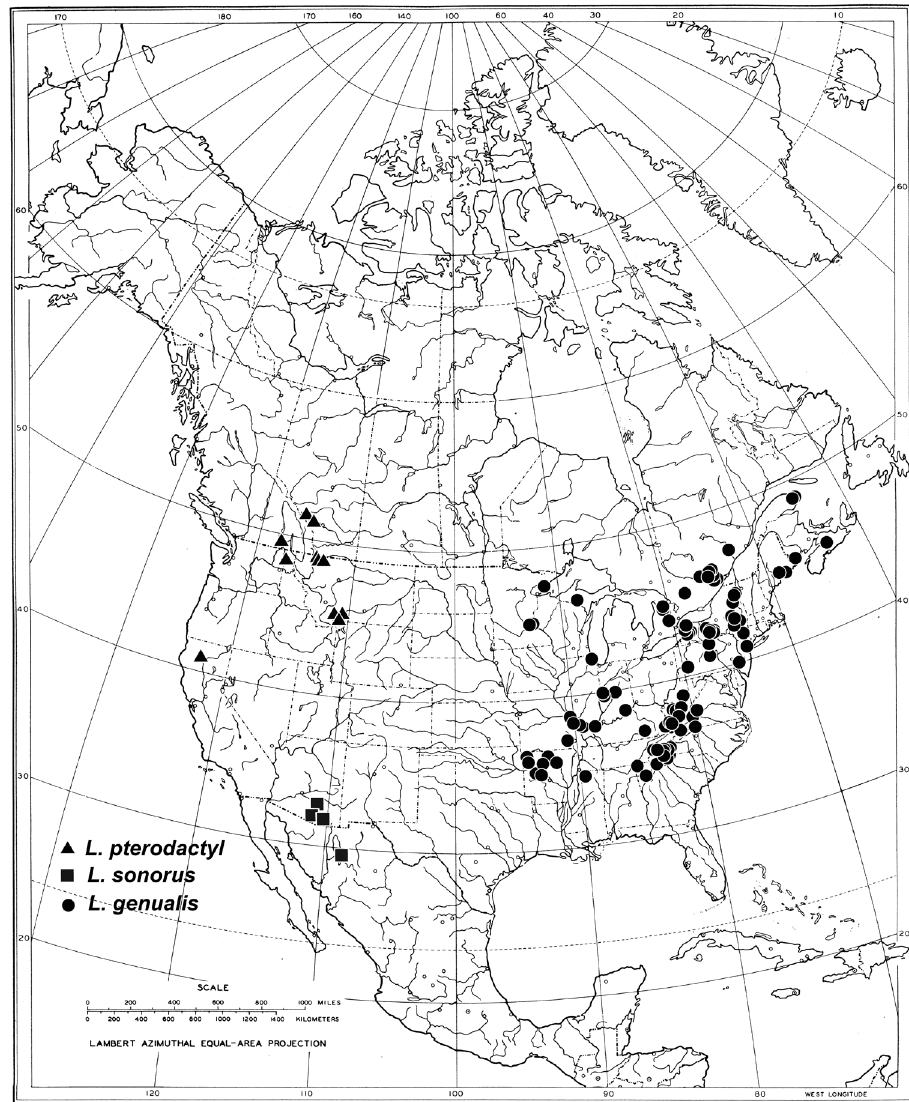
Figure 13. Known distributions of Liancalus pterodactyl sp. n., L. sonorus sp. n . , and L. genualis Loew.